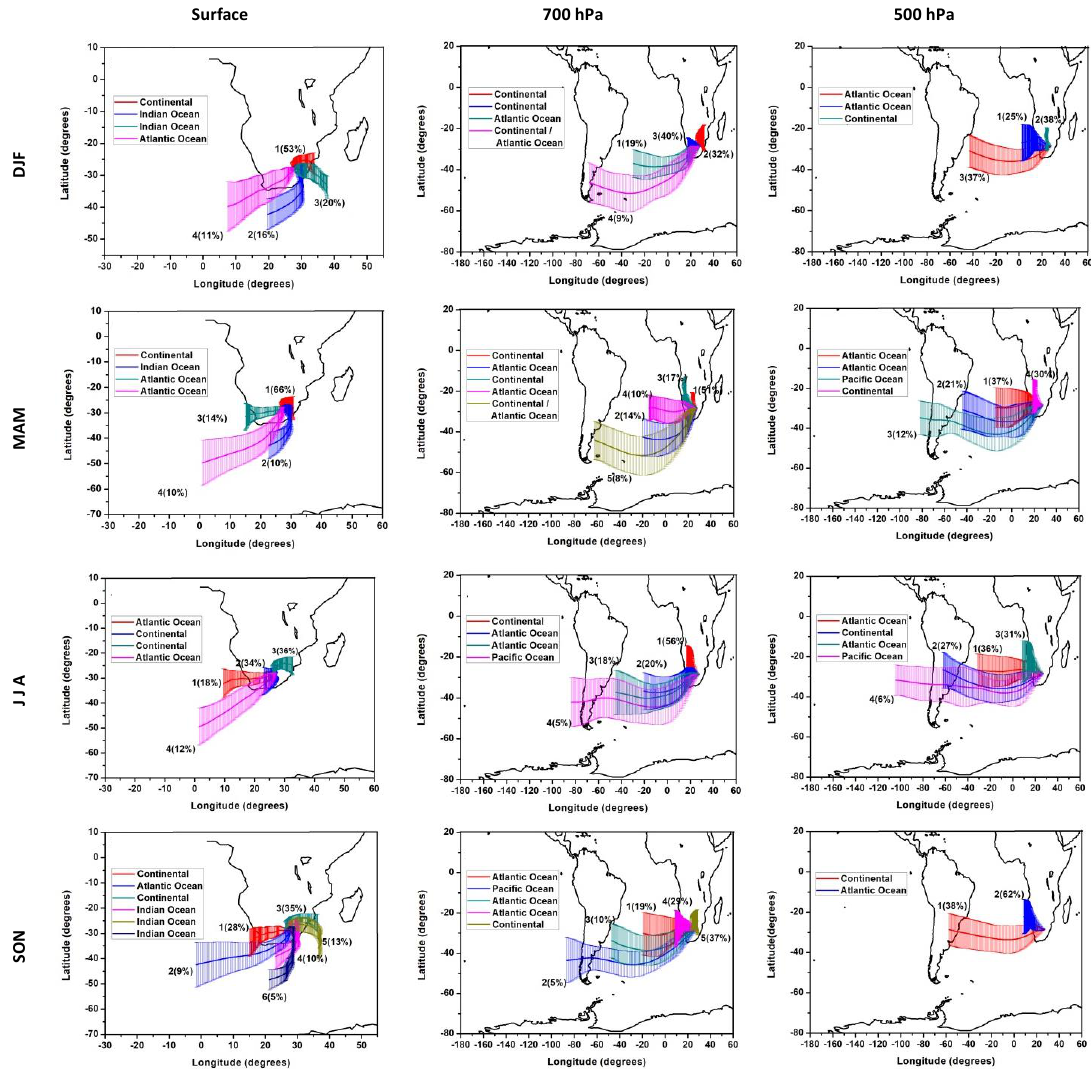
Figure 7. Seasonal 5-day backward trajectories illustrating air transport with its frequency impacting on CO 2 mixing ratios at the surface, above 3400, and 5500 m stable layers at Central Interior of South Africa area. From ( top ) to ( bottom ) row is the seasonal change from DJF to SON, while the ( left ), ( middle ), and ( right ) columns represent atmospheric layers at the surface, above 3400, and 5500 m stable layers, respectively.